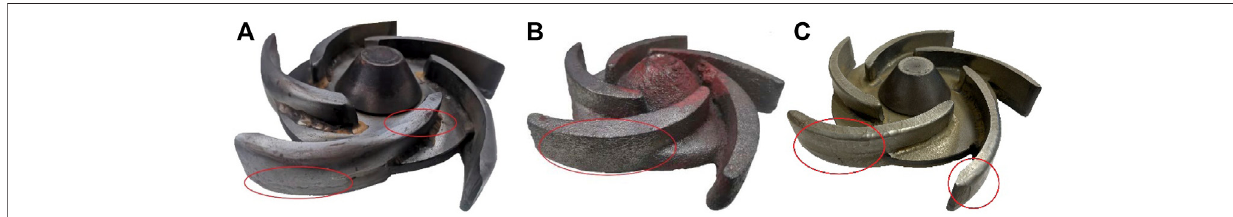
FIGURE 14 | Blade wear under different materials. (A) 16 Mn, (B) HT200, and (C) Q235.